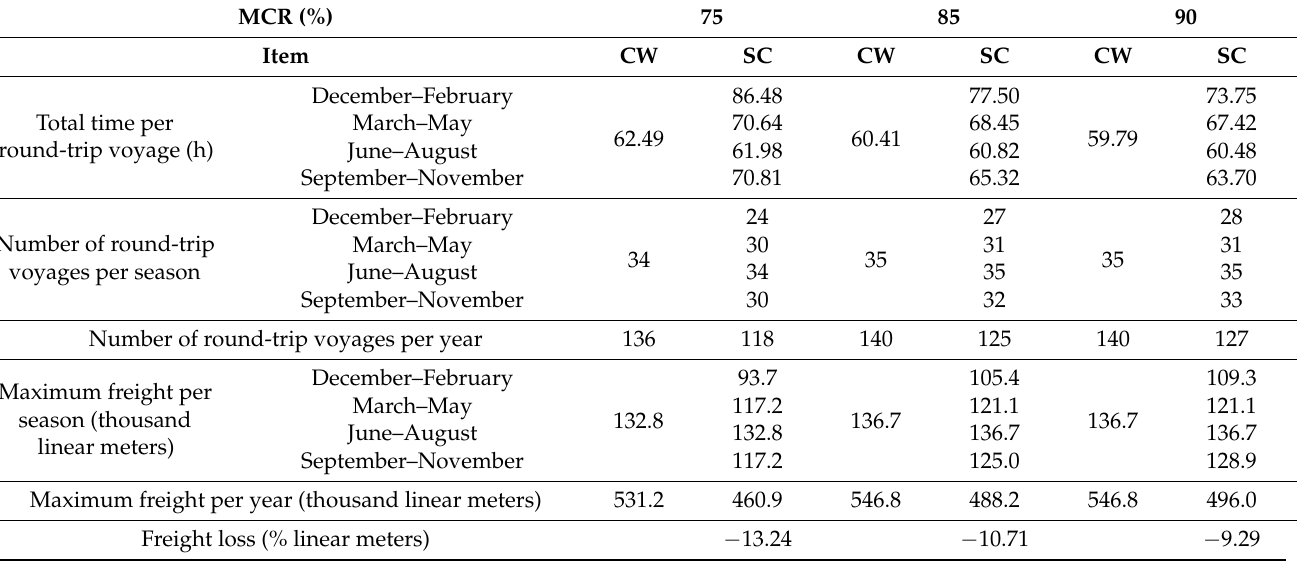
Table 11. Estimation of freight loss for Load Condition